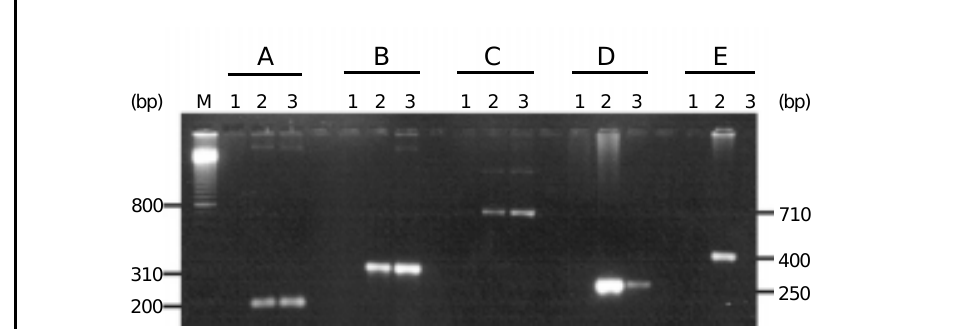
Figure 2. Specific PCR for am- plification of nif genes from Azospirillum amazonense . Am- plified products on 1.5% aga- rose gel were visualized with a UV transilluminator after ethi- dium bromide staining using the following primers: panel A